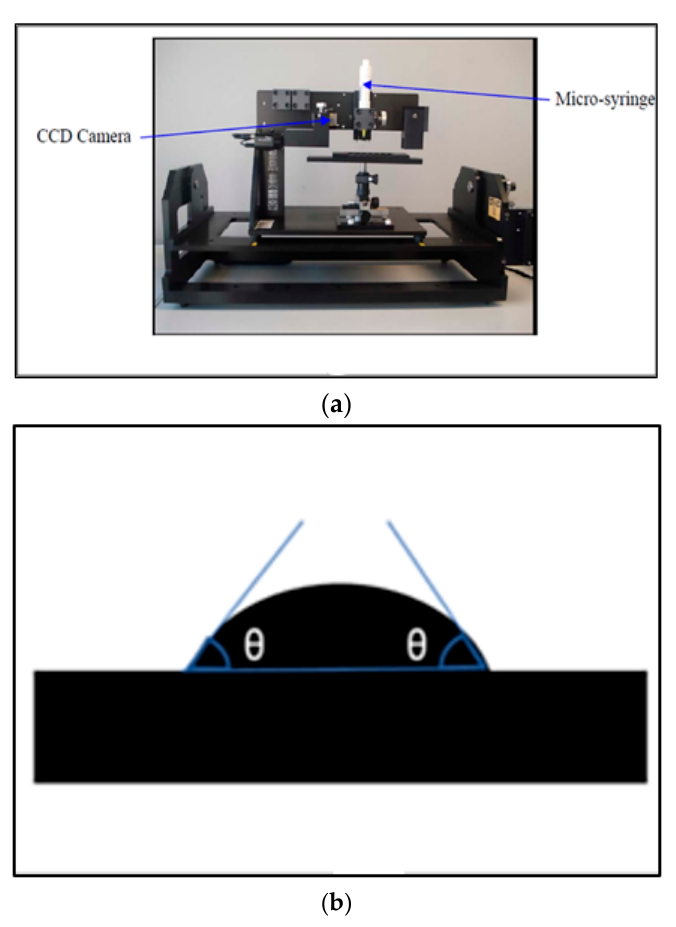
Figure 2. ( a ) Sessile drop device; ( b ) Sketch of Sessile drop contact angle measurement.